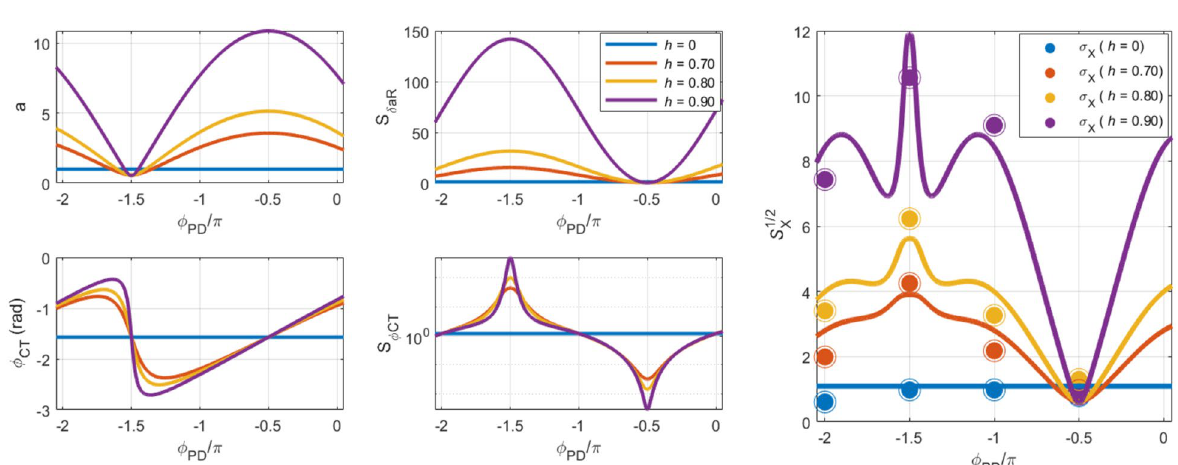
Figure 5. Left: Adimensional amplitude and phase of a parametrically pumped microresonator in open-loop; Center: PSD of the real part of the amplitude noise and phase noise in open-loop; Right: PSD of the X value in open-loop, calculated with Eq. (8), as function of the parametric gain and phase φ PD . The standard deviation of the X values measured experimentally in open-loop (see Fig. S5 of the Supplementary Material) are added to the PSD modelled